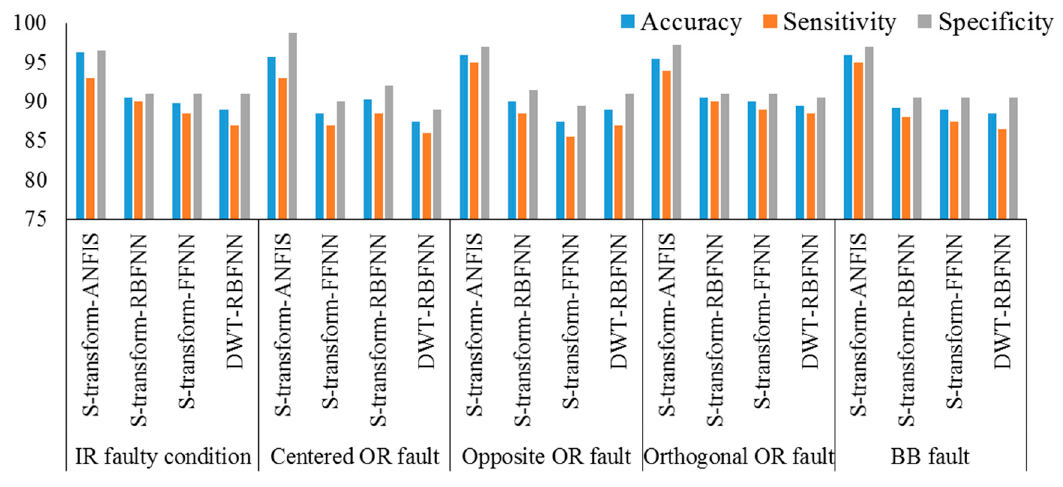
Figure 12. Results for the study by Gnanaprakasam (2015) [67].